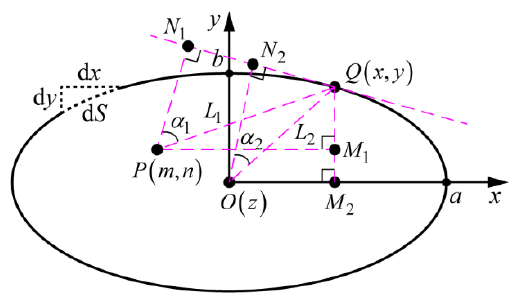
Figure 14. Relationship of OQ and PQ on the elliptical envelope.